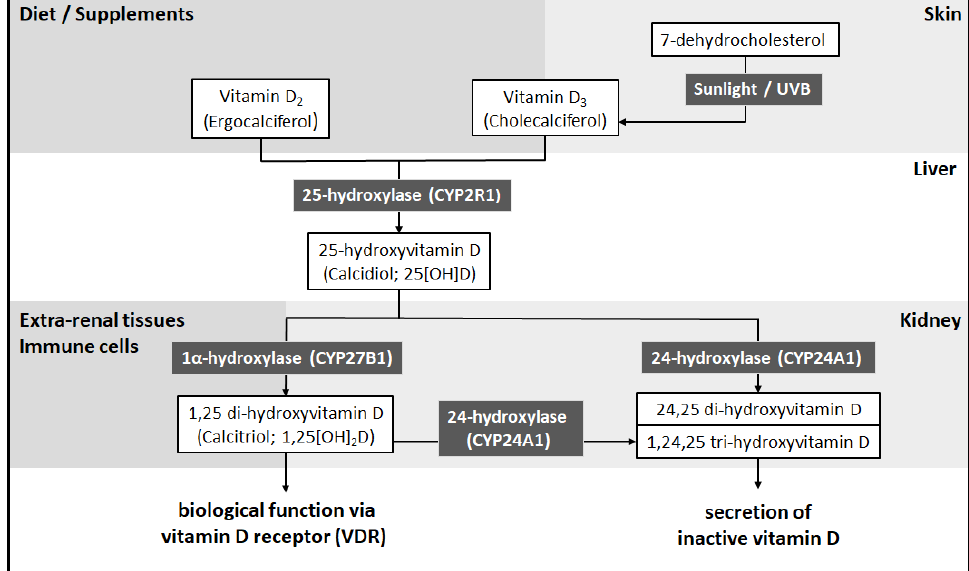
Figure 1. Metabolism of vitamin D. Vitamin D can be either produced in the skin upon UVB radiation or ingested through dietary intake. Vitamin D (representing vitamin D 2 and D 3 ) is converted by 25-hydroxylase (CYP2R1) in the liver to 25[OH]D. 25[OH]D is converted in the kidneys and several extrarenal tissues, including immune cells, by 1 α -hydroxylase (CYP27B1) to 1,25[OH] 2 D. 1,25[OH] 2 D, the biologically active form of vitamin D, binds to the vitamin D receptor to carry out its biological function. To avoid overwhelming vitamin D stimulation, 24-hydroxylase (CYP24A1) further catabolizes 25[OH]D and 1,25[OH] 2 D to 24,25 dihydroxyvitamin D (24,25[OH] 2 D) and 1,24,25[OH] 3 D for excretion in the kidneys. Notably, although not depicted in the present figure, the binding of vitamin D and its metabolites to DBP is required for their transportation in the circulation. Abbreviations: 1,25[OH] 2 D—1,25 dihydroxyvitamin D; 25[OH]D—25-hydroxyvitamin D; 24,25[OH] 2 D—24,25 dihydroxyvitamin D; 1,24,25[OH] 2 D—1,24,25 tri-hydroxyvitamin D; and D-binding protein—DBP.